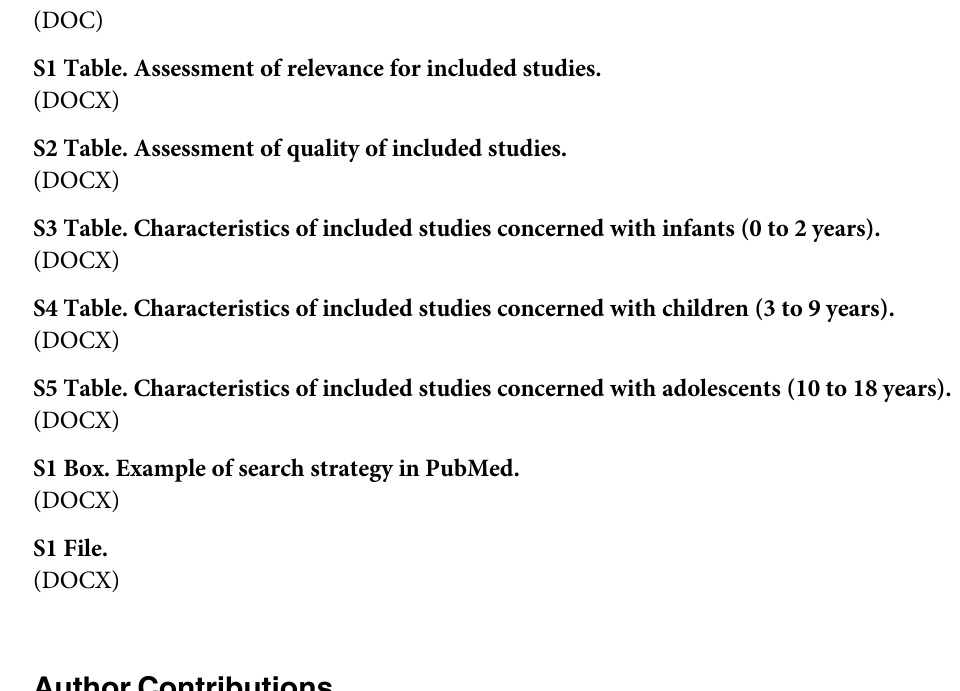
S1 Table. Assessment of relevance for included studies. S2 Table. Assessment of quality of included studies. S3 Table. Characteristics of included studies concerned with infants (0 to 2 years). S4 Table. Characteristics of included studies concerned with children (3 to 9 years). S5 Table. Characteristics of included studies concerned with adolescents (10 to 18